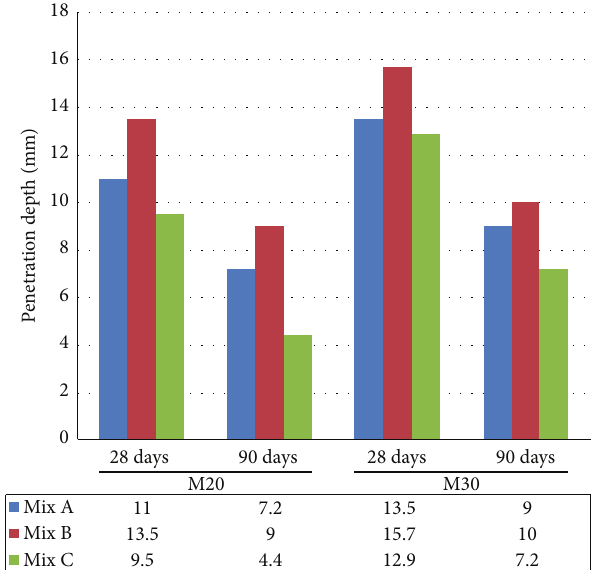
Figure 10: Comparative sorptivity test of Mix A, Mix B, and Mix C of M20 and M30 grade. Figure 11: Comparative water penetration test of Mix A, Mix B, and Mix C of M20 and M30 grade.